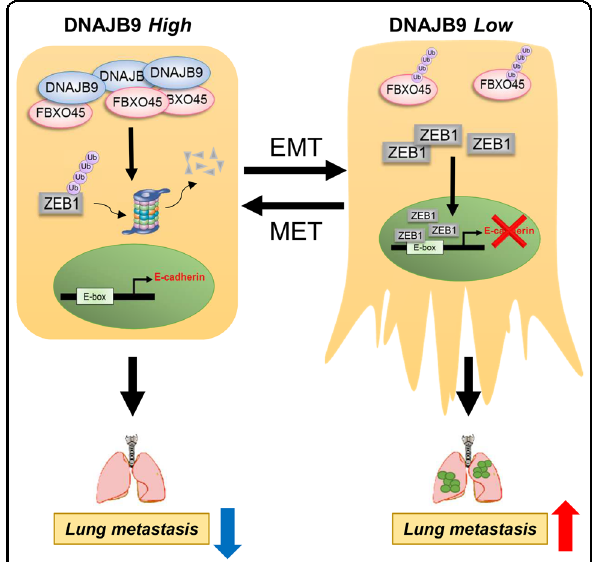
Fig. 6 A proposed model for the role of DNAJB9 in breast cancer metastasis. With a high level of DNAJB9, FBXO45 was stabilized by interacting with DNAJB9 and induced the proteasomal degradation of ZEB1 through K48-mediated ubiquitination in non-TNBC cells. As a result, the epithelial – mesenchymal transition (EMT) process was suppressed by inducing the transcription of epithelial cell markers, followed by the inhibition of metastasis into the lungs. However, the loss or low level of DNAJB9 allowed the expression of ZEB1 to inhibit the transcription of E-cadherin and resulted in EMT progression. Finally, TNBC cells can metastasize into the lungs and threaten patient